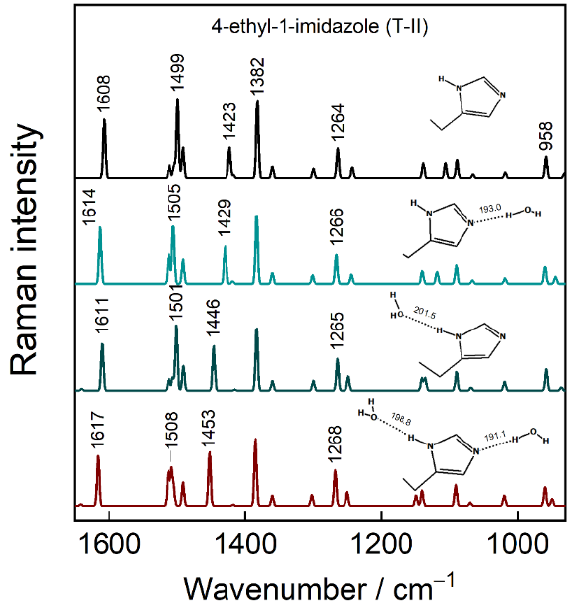
Figure 9. DFT spectra and optimized structures of Tautomer-II form of model compound 4-ethyl-1- imidazole with H-bonding coordination number from 0 to 2. The lengths of H-bonds are indicated in pm.